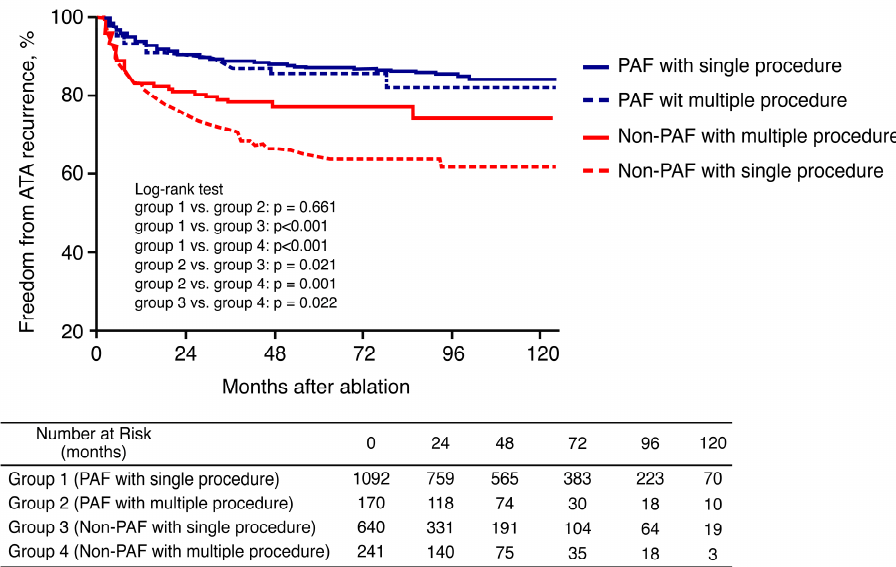
Figure 5. Kaplan–Meier curves according to AF type and number of procedures.